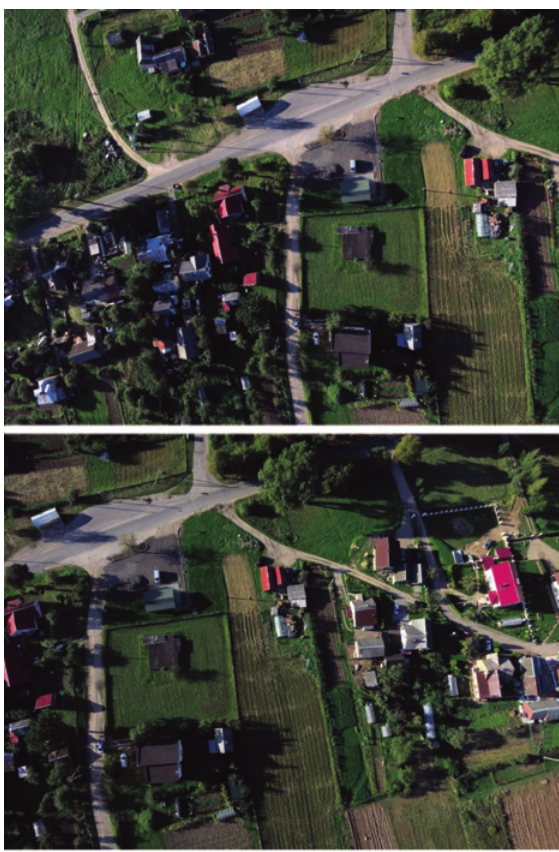
Fig. 5. Stereo pair (left and right) selected for photogrammetric image